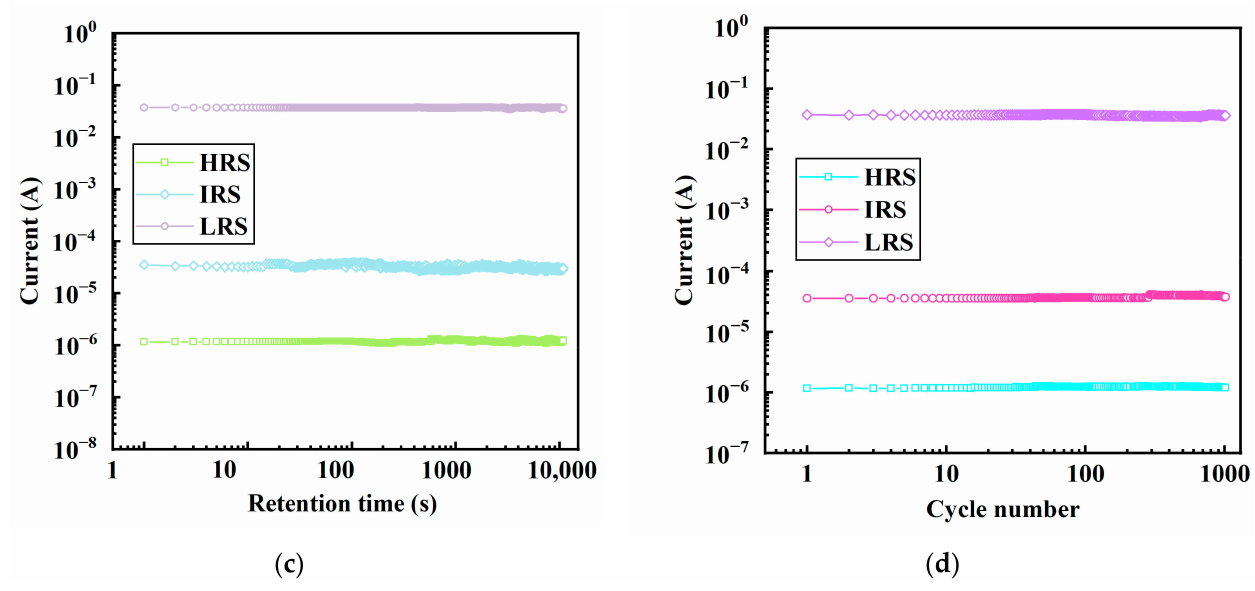
Figure 6. ( a ) The retention performance. ( b ) Endurance performance of the sample A device; ( c ) The retention performance. ( d ) Endurance performance of the sample E-based device.